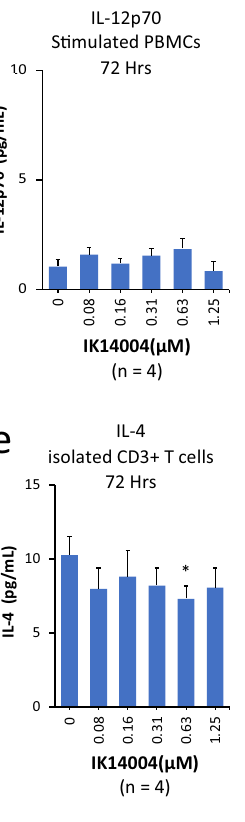
Figure 4. IK14004 regulates the IL-12p70: IL-12p40 ratio both in the absence and presence of APCs. Experiments with PBMCs or isolated CD3+ T cells were performed using triplicate wells (technical replicates) for each experiment and ELISA experiments were repeated four times (n = 4) as indicated below each panel. All error bars represent standard error of the mean (SEM). In all experiments the culture duration was 72 h. The compound shown is IK14004 as indicated under each panel. ( a ) IL-12p70 levels in supernatant from PBMC cultures. ( b ) IL-12p40 levels in supernatant from PBMC cultures. ( c ) IL-12p40 levels in supernatant from T cell cultures. ( d ) IL-12p70 levels in supernatant from T cell cultures. ( e ) IL-4 levels in supernatant from T cell cultures. Data were analysed using repeated measures (RM) two-way ANOVA with Dunnett’s post-test comparing peptide with vehicle control. *P < 0.05, **P < 0.01, ***P < 0.001, ****P <